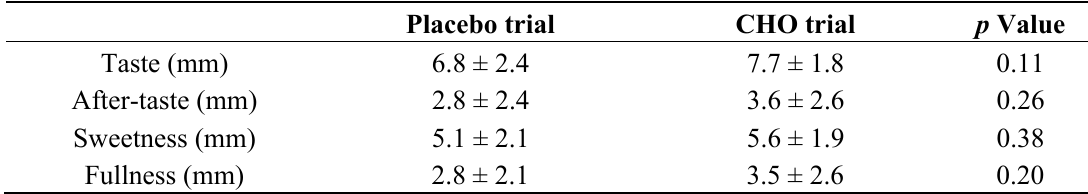
Table 2. Palatability of CHO and placebo